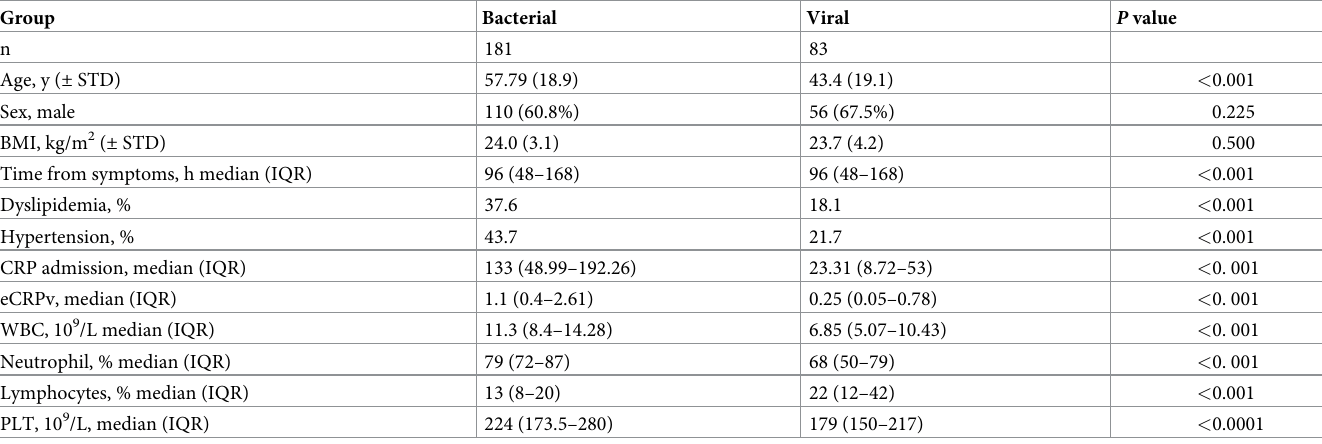
Table 1. Study population characteristics.